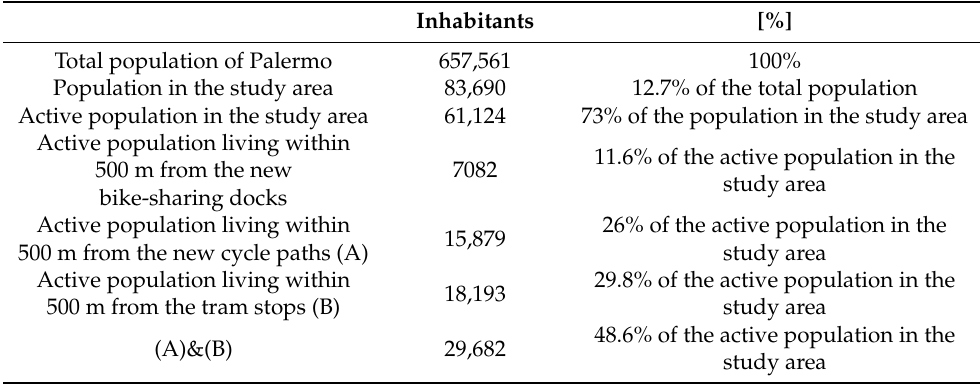
Table 2. Census data (2018) and active population living within 500 m of the new bike-sharing docks and the public transport services with high cumulative frequency.